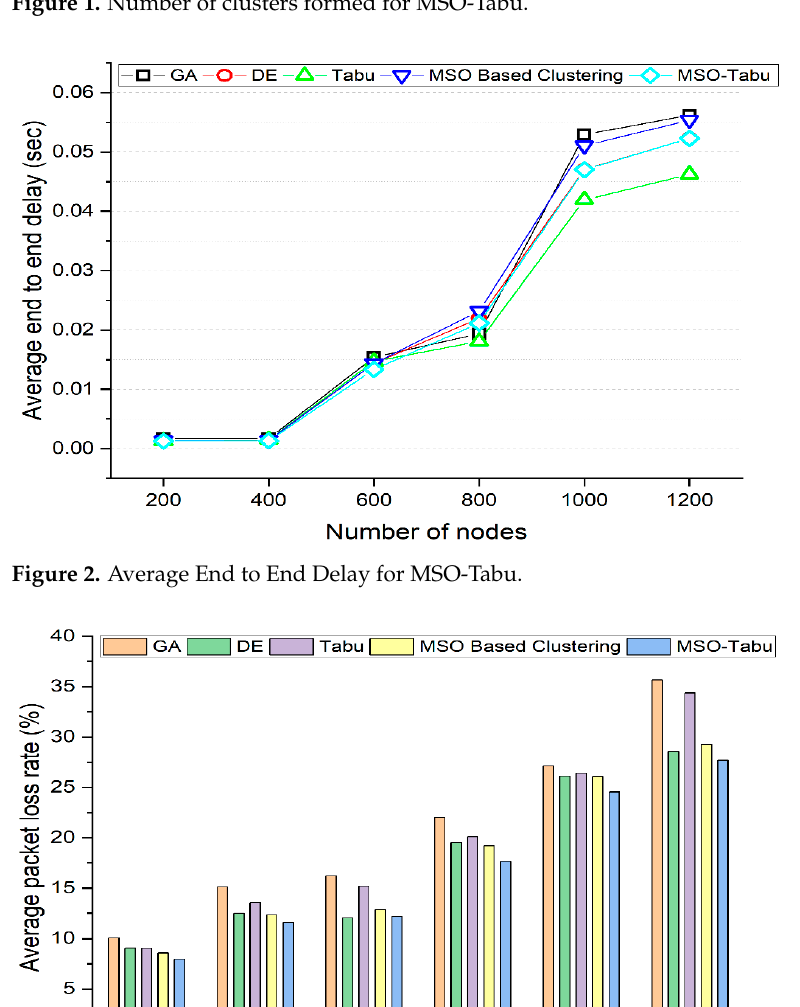
Figure 3. Average Packet Loss Rate for MSO-Tabu. From Figure 4, it can be observed that the MSO-Tabu has higher lifetime computation by 0%, 4%, 2%, 8%, 10%, 24%, 41%, and 1000% for GA and by 0%, 0%, 1%, 3%, 8%, 7%, 94%, and 175% for DE when compared for 0, 100, 200, 300, 400, 500, 600, and 700 number of rounds respectively. For the same numbers of round, MSO-Tabu also reports better lifetime characteristics by 0%, 3%, 2%, 7%, 10%, 22%, 41%, and 1000% for Tabu and 0%, 0%, 1%, 2%, 8%, 9%, 107%, and 175% for MSO based clustering algorithm respectively.